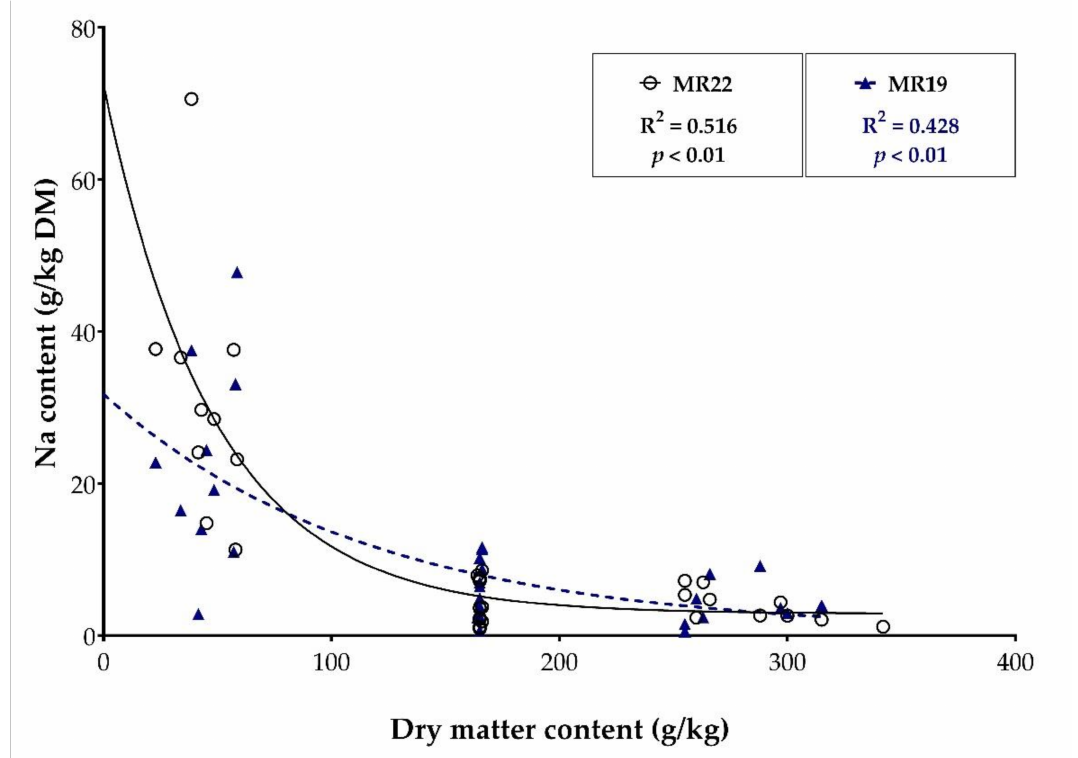
Figure 3. Correlation coefficients with significance levels between the dry matter content (g/kg) and sodium content (g/kg DM) of the fecal samples measured in calves fed with milk replacer content 22% CP (MR22; n = 31) or 19% CP (MR19; n = 30). The sodium content was particularly high in the fecal samples with lower DM content but differed barely between medium and high DM content in the feces (Table